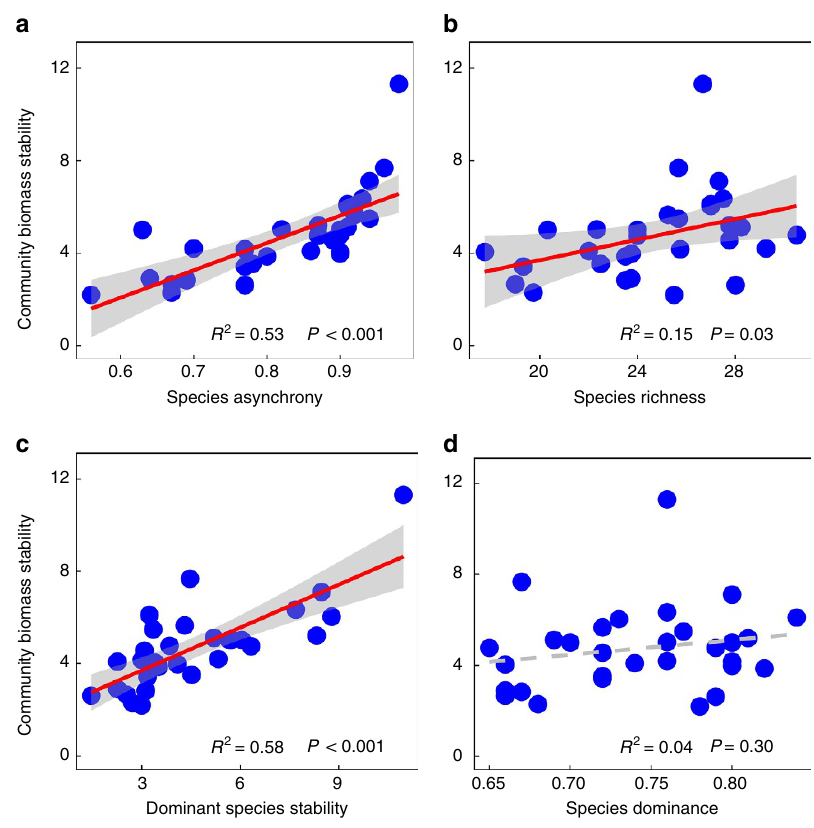
Figure 3 | Relationships between ecological factors and community biomass stability. Shown are ( a ) species asynchrony (linear regression; P o 0.001); ( b ) species richness (linear regression; P ¼ 0.03); ( c ) dominant species temporal stability (linear regression; P o 0.001); and ( d ) Simpson’s dominance (linear regression; P ¼ 0.30). The red solid lines are significant regression lines, and the grey dashed lines are nonsignificant regression lines. Each blue circle represents an experimental plot ( n ¼ 30). Shaded areas represent 95% confidence